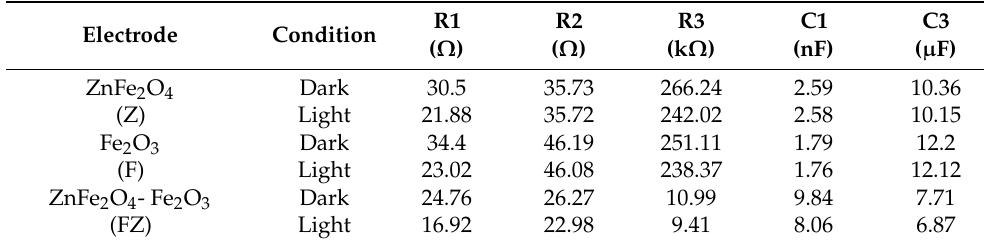
Tafel plots of the fabricated Z, F, and ZF anodes were recorded to realize the hydrogen evolution mechanism in 0.1 M KOH aqueous electrolyte under dark and light conditions. The plotted Tafel data for the synthesized Z, F, and ZF anodes were presented in Figure 7. All the nanostructures exhibited a shift in voltage towards the anode under a light